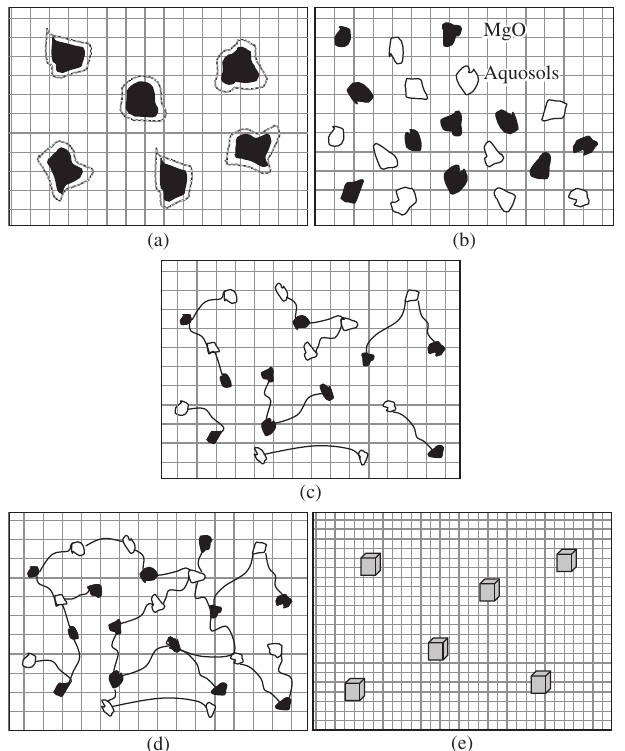
Figure 1. Scheme of the formation of CBPCs (chemically bonded phosphate ceramics): a) Dissolution of oxides; b) formation of aquosols; c) acid-base reaction and condensation; d) percolation and formation of gel; e) crystal- lization and saturation of gel into a ceramic 3